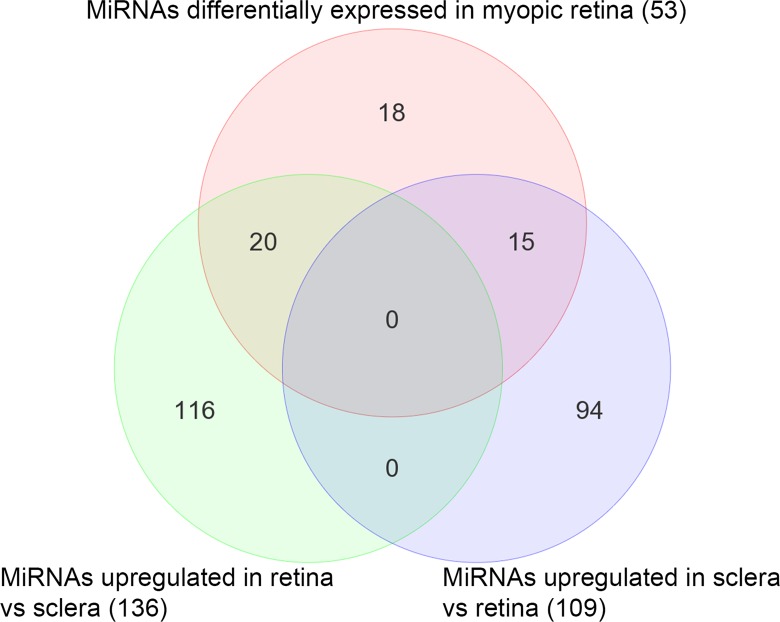
Overlap between miRNAs differentially expressed in the myopic retina and miRNAs differentially expressed in the retina versus sclera.Venn diagram shows overlap between 53 miRNAs, which were differentially expressed in the myopic retina, 136 miRNAs, which were up-regulated in the retina versus sclera, and 109 miRNAs, which were up-regulated in the sclera versus retina. Eighteen differential miRNAs were equally expressed in both retina and sclera, 20 differential miRNAs were up-regulated in the retina versus sclera and 15 differential miRNAs were down-regulated in the retina versus sclera.